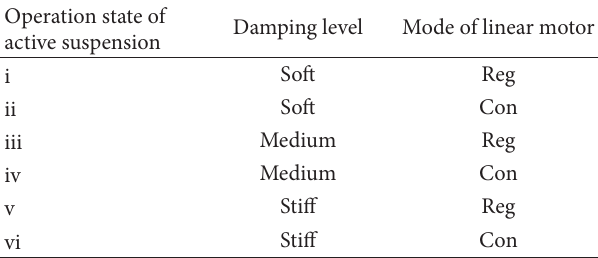
Table 3: Relations between 𝑁 and the motor mode under different damping